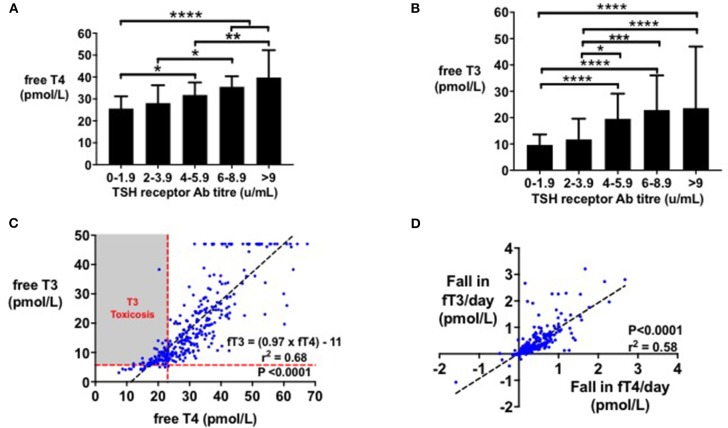
(A) Bar graph (median with IQR) of initial fT4 (pmol/l) by initial TSHR antibody titre (mU/l). Initial fT4 (pmol/l) increased with TSHR antibody titre (*P < 0.05, **P < 0.01, ****P < 0.0001). Initial fT4 levels were predicted by initial TSHR antibody titre (r2 = 0.11, P < 0.0001). (B) Bar graph (median with IQR) of initial fT3 (pmol/l) by initial TSHR antibody titre (mU/l). Initial fT3 (pmol/l) increased with TSHR antibody titre (*P < 0.05, ***P < 0.001, ****P < 0.0001). Initial fT3 levels were predicted by initial TSHR antibody titre (r2 = 0.12, P < 0.0001). (C) Scattergraph of initial fT4 (pmol/l) by initial fT3 (pmol/l). Initial fT4 and fT3 increased in an ~1:1 ratio, with fT4 predicting fT3 levels (fT3 = (0.97 × fT4)-11, r2 = 0.68, P < 0.0001). (D) Scattergraph of fall in fT3 (pmol/l) per day by fall in fT4 (pmol/l) per day, following 4 weeks' of treatment with carbimazole. Fall in fT4 per day (pmol/l) predicted fall in fT3 per day (pmol/l) by the equation: Fall in fT3 per day = 0.9541* Fall in fT4/day + 0.02, r2 = 0.58, P < 0.0001.